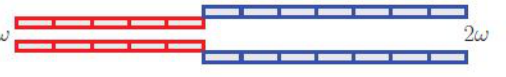
Figure 9. Scheme of frequency doubler operation.